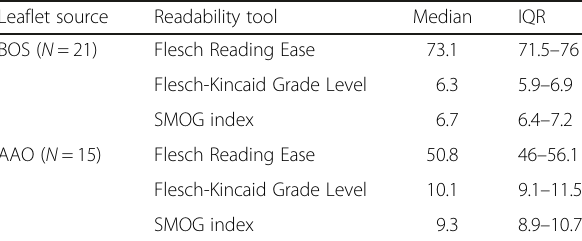
Table 4 Median readability scores for BOS and AAO PILs Leaflet source